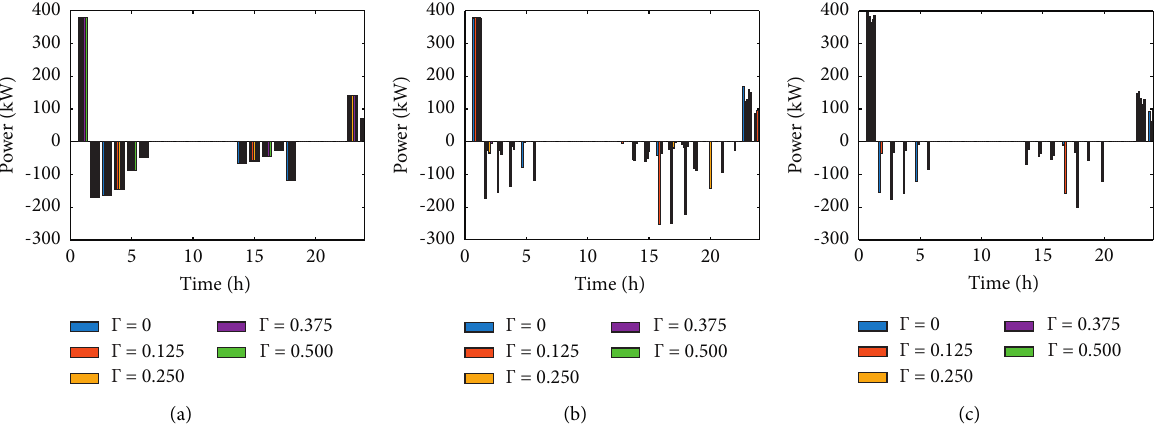
Figure 7: Comparison of the discharging of ESS between the RMPC method and the traditional MPC. (a) WI1 � 0.0%. (b) WI2 � 2.5%. (c) WI3 �